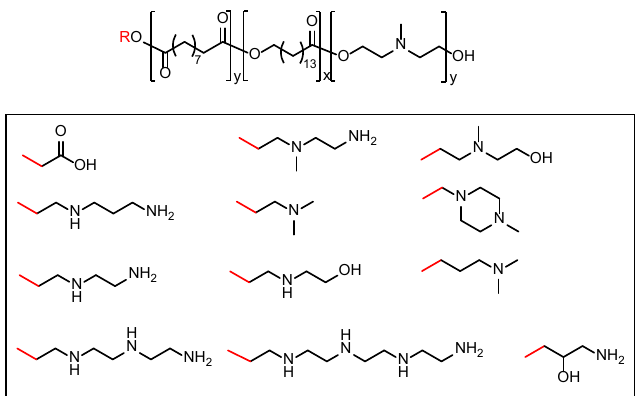
Figure 6 . Representative chemical structure of